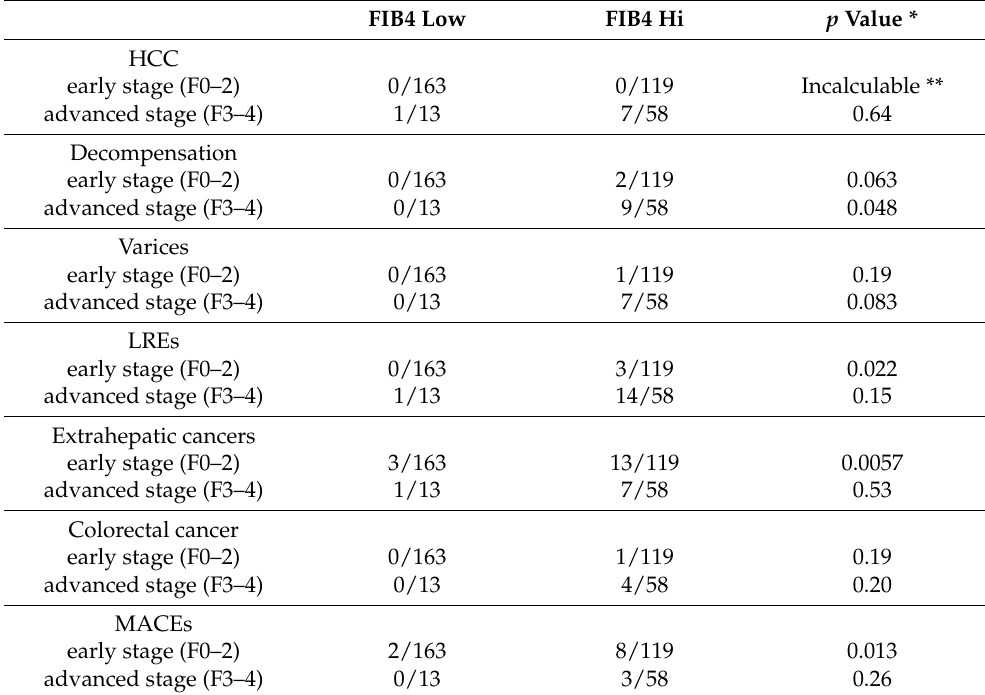
Table 3. Comparison of the number of each event by FIB-4 index and degree of liver fibrosis. FIB4 Low FIB4 Hi p Value